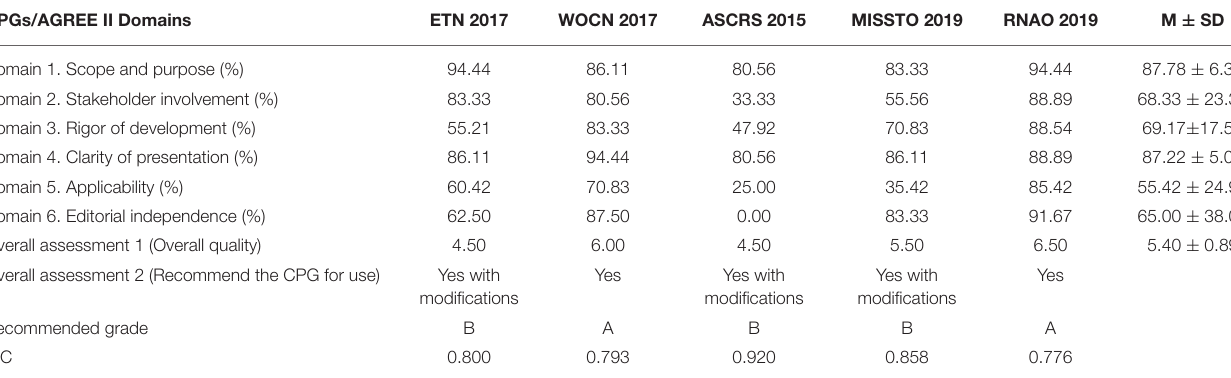
TABLE 3 | Scores of the domains and overall assessment of the CPGs for ostomy care based on the AGREE II instrument. CPGs/AGREE II